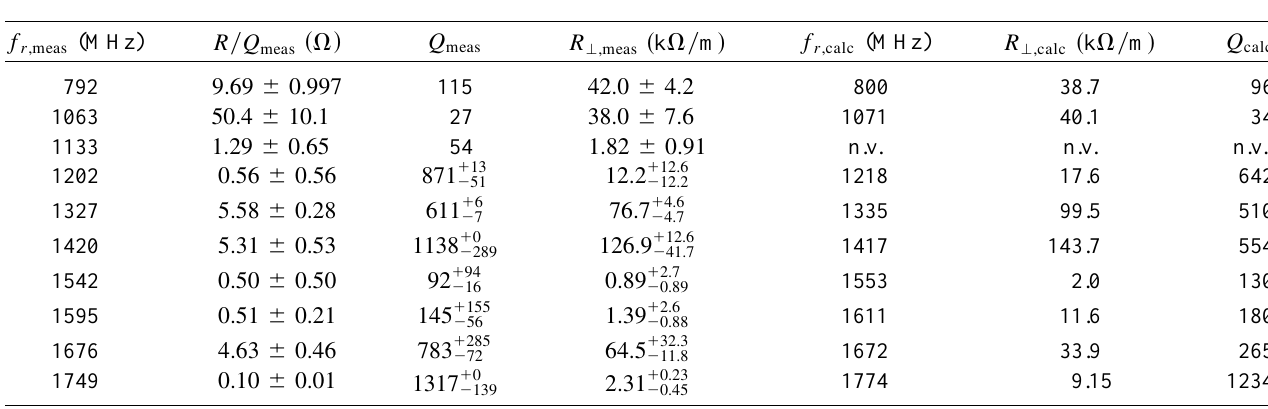
TABLE II. Transverse impedance and Q ’s of dipole modes estimated from calculations and measurements. R (cid:1) (cid:1) (cid:4) R (cid:1)(cid:2) Qkr 2 (cid:3)(cid:5) Q L . The measured R (cid:1) Q is at a 4 cm offset. n.m. (cid:1) not measured, n.v. (cid:1) not visible. f r ,meas